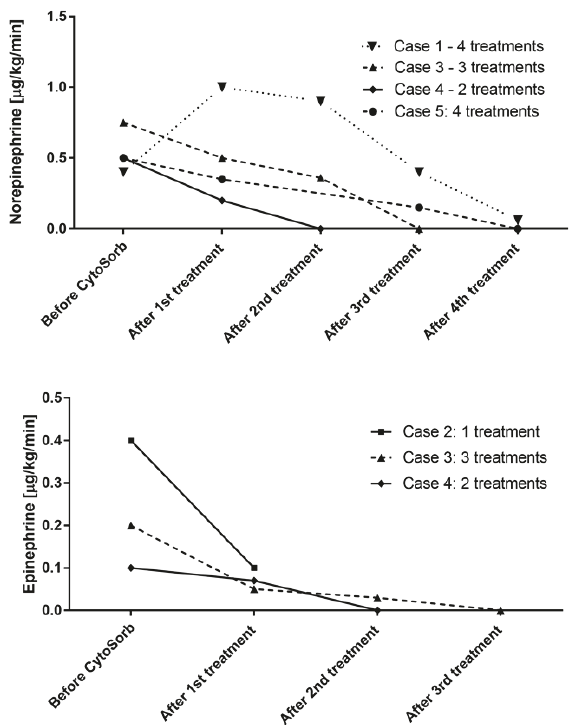
Figure 1: Course of norepinephrine and epinephrine demand during Cytosorb treatment in all treated patients. Values are shown at the beginning of the treatment and after every treatment until the